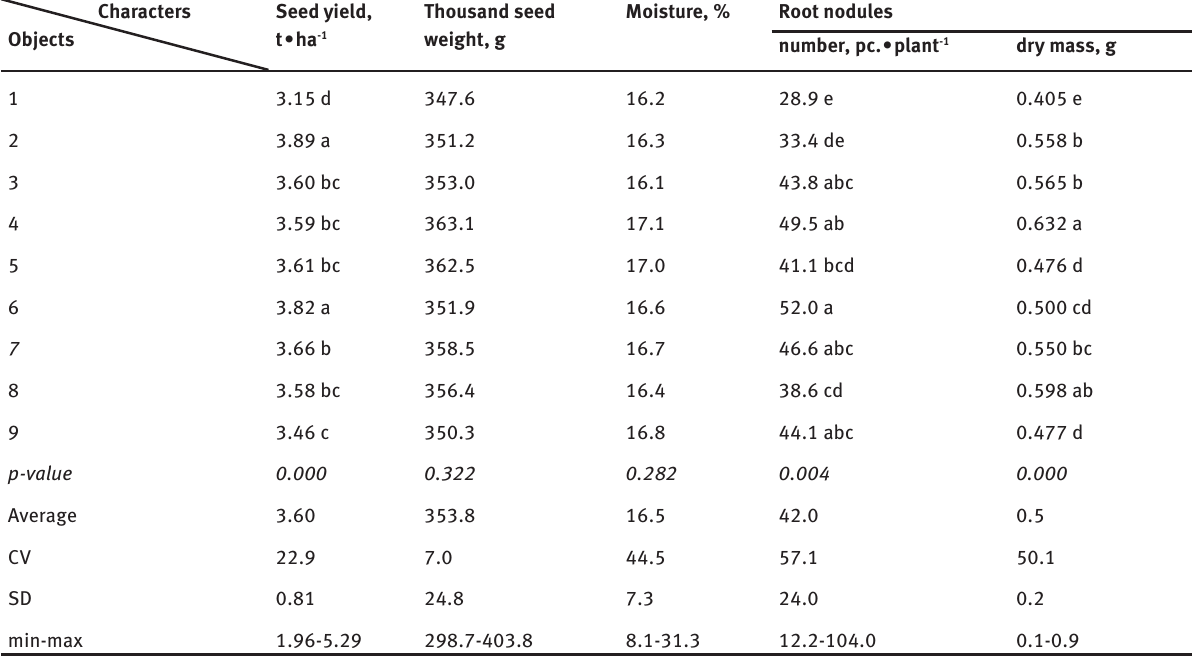
Table 1: Influence of vaccination treatment in white lupine seeds on yield, its moisture and root nodule. Characters